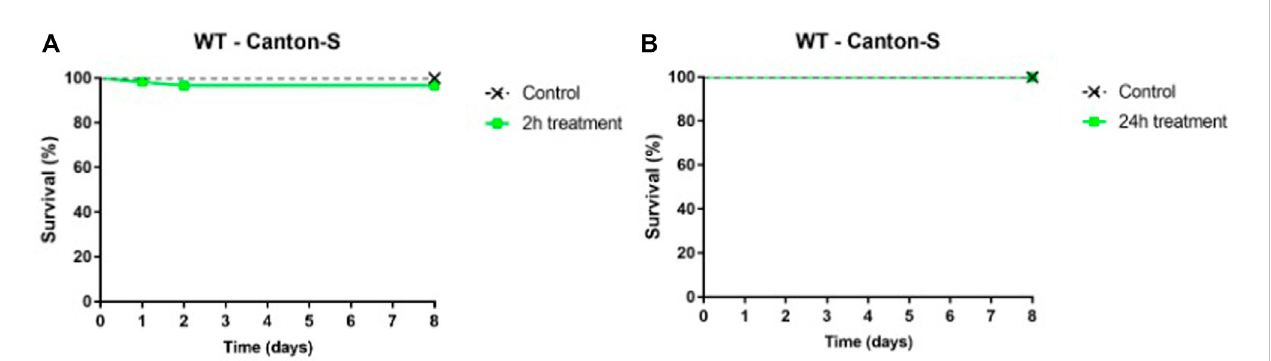
FIGURE 8 Kaplan-Meier survival curves of WT – Canton-S fl ies fed a medium containing Ag@ACF-treated water for (A) 2 and (B) 24 h and standard culture medium (control). Dashed line represents the longevity of the group fed a medium containing Ag@ACF-treated water (green) and negative control (standard medium) (black). n = 20 fl ies/group.